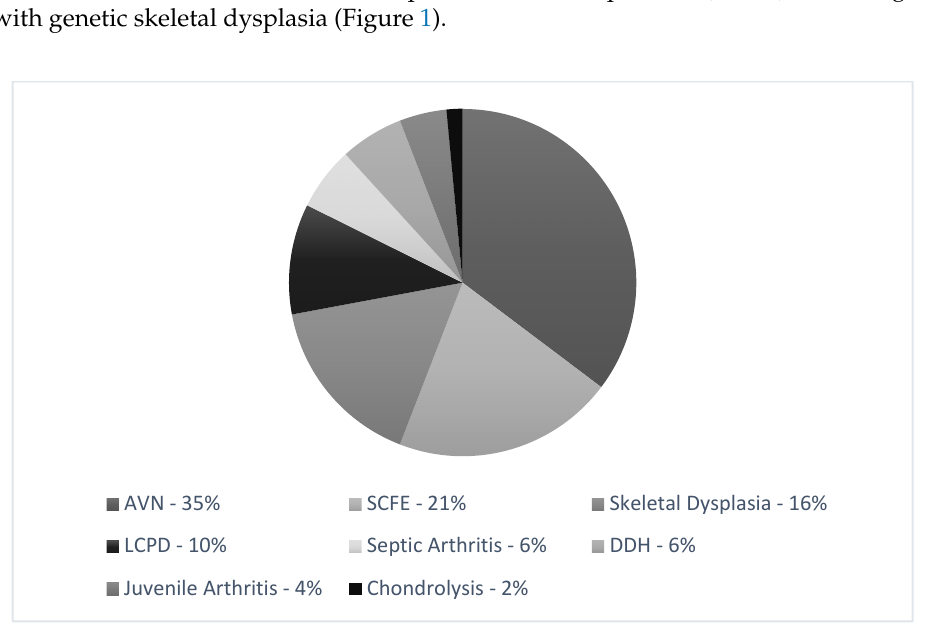
Table 3. Implants characteristics.